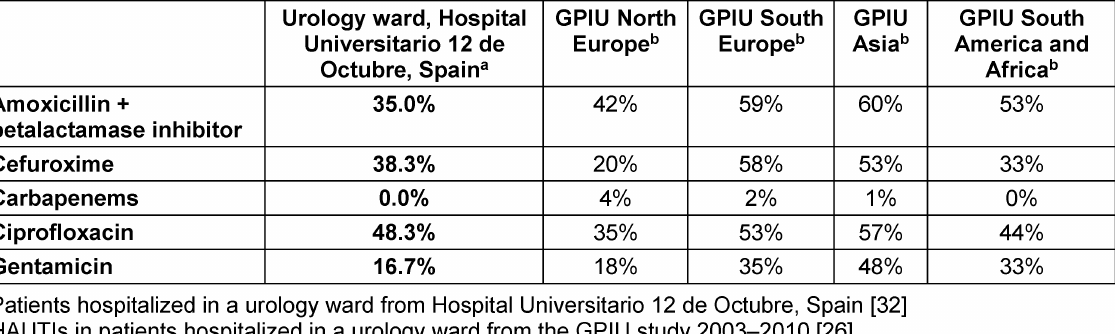
Table 2: E. coli resistance rate in patients with HAUTIs hospitalized in